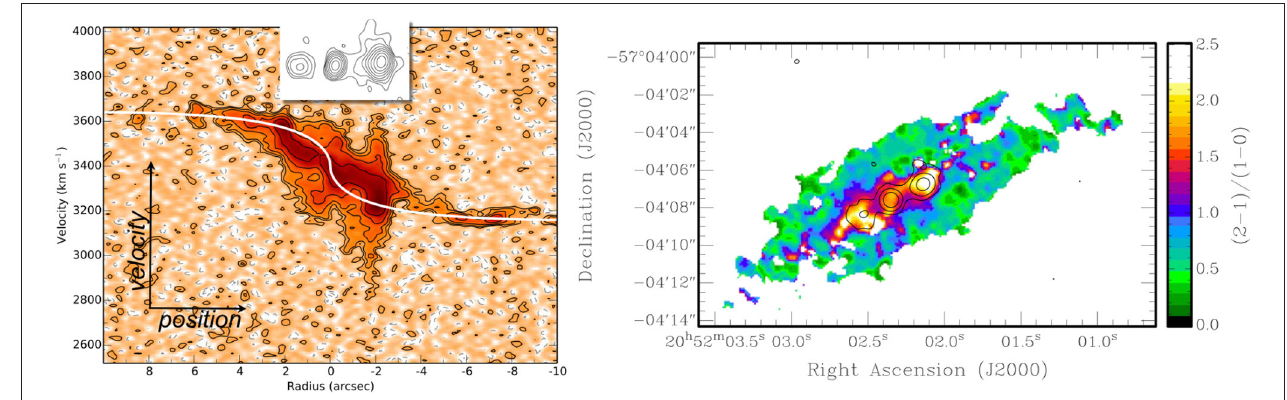
FIGURE 4 | ALMA observations of IC 5063. Left: integrated position-velocity map of the CO(2-1) along the radio axis of IC 5063. The white line indicates the expected kinematics of gas following regular rotation (figure modified from Morganti et al., 2015a, reproduced with permission © ESO). Right: Ratio CO(2-1)/CO(1-0) integrated brightness temperatures I (in K kms − 1 ), courtesy of T. Oosterloo. Overplotted are the contours of the 346 GHz continuum emission of IC 5063 (see also Oosterloo et al.,